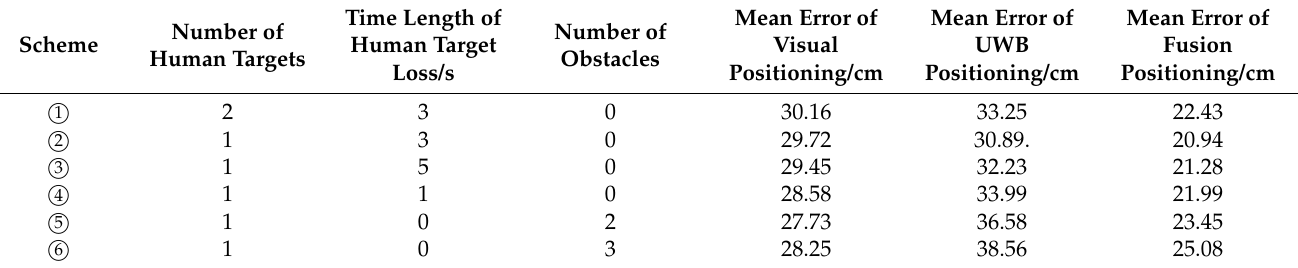
Table 1. Positioning results under different experimental conditions.